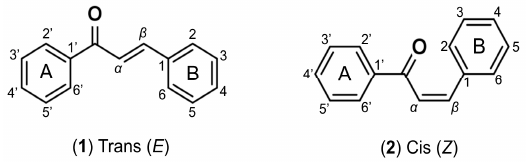
Figure 1. Structural and numerical representations of chalcone scaffold.